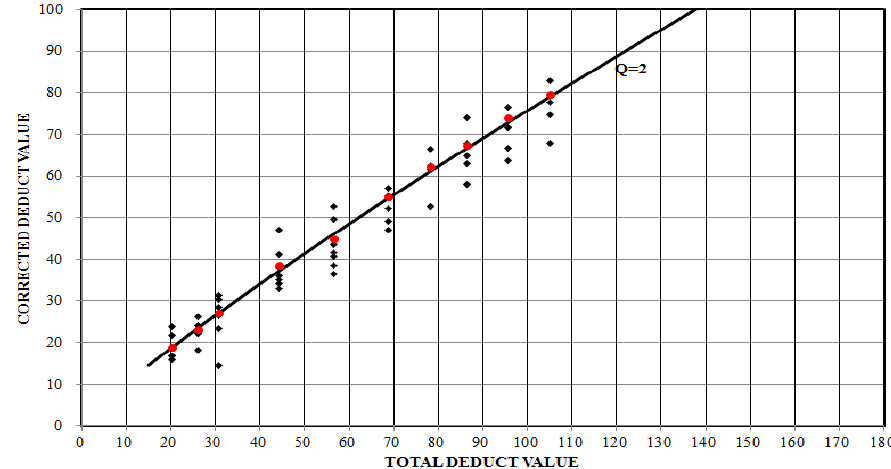
Figure 8. Example of the developed CDV for a case with two or more distress types or severity levels in the asphalt pavements.